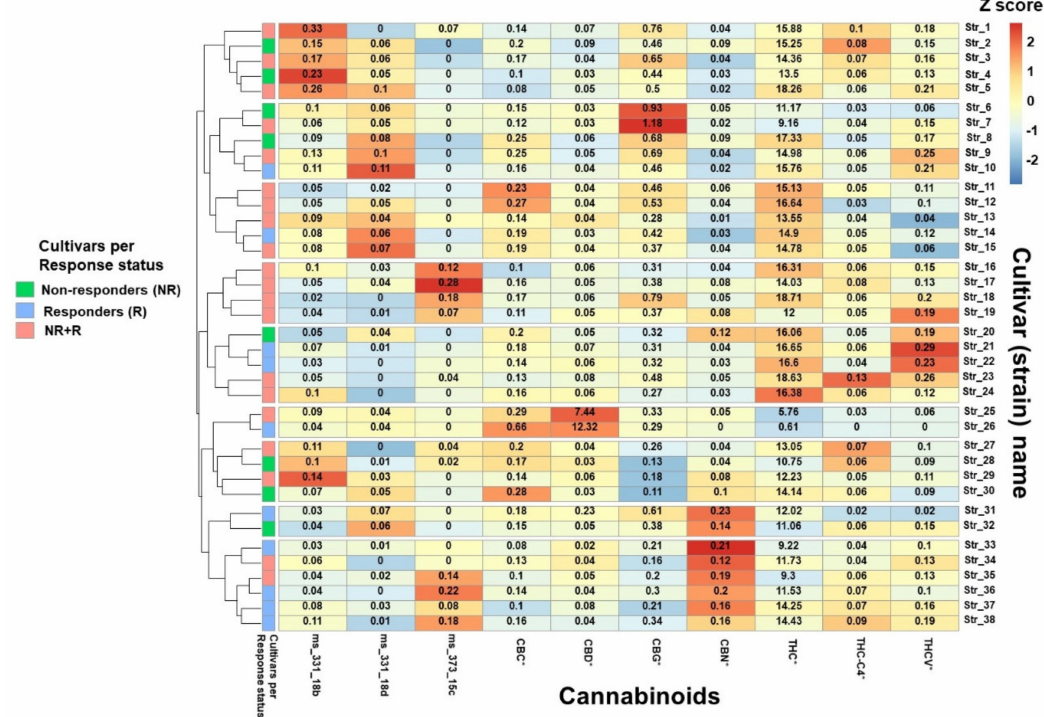
Figure 2. Relative phytocannabinoid concentrations in the most frequently consumed cultivars. Colors on the graph represent the scaled phytocannabinoid concentration variations between cultivars; the numbers in each box represent the concentration (% w / w) of the specific phytocannabinoid within each